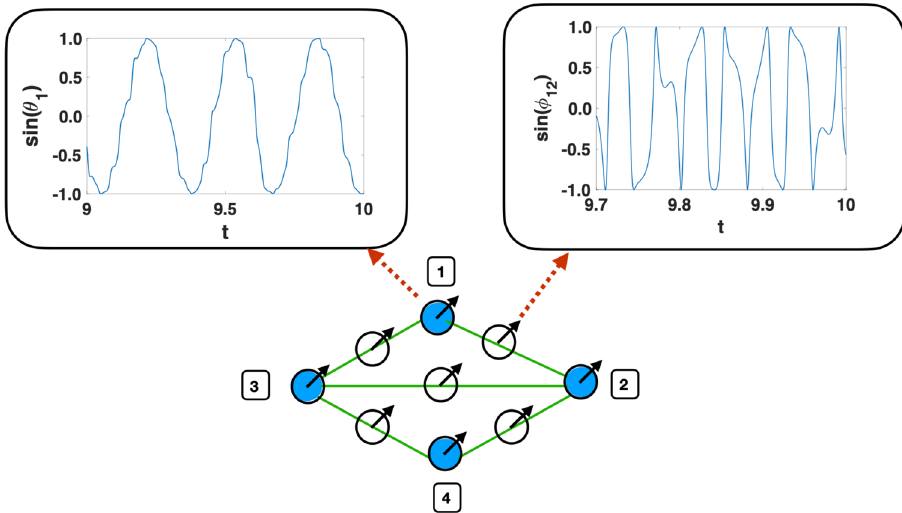
Fig. 1 Schematic representation of topological signals de fi ned on the nodes and the links of a network. In Dirac synchronization topological signals associated to the nodes and the links of a network are coupled locally thanks to the Dirac operator. The considered topological signals are the phases of oscillators associated to nodes (blue oscillator symbols placed on nodes) or to links (non- fi lled oscillator symbols placed on links) of a network. The two insets show schematically the time-series of node [1] and link [1, 2] signals